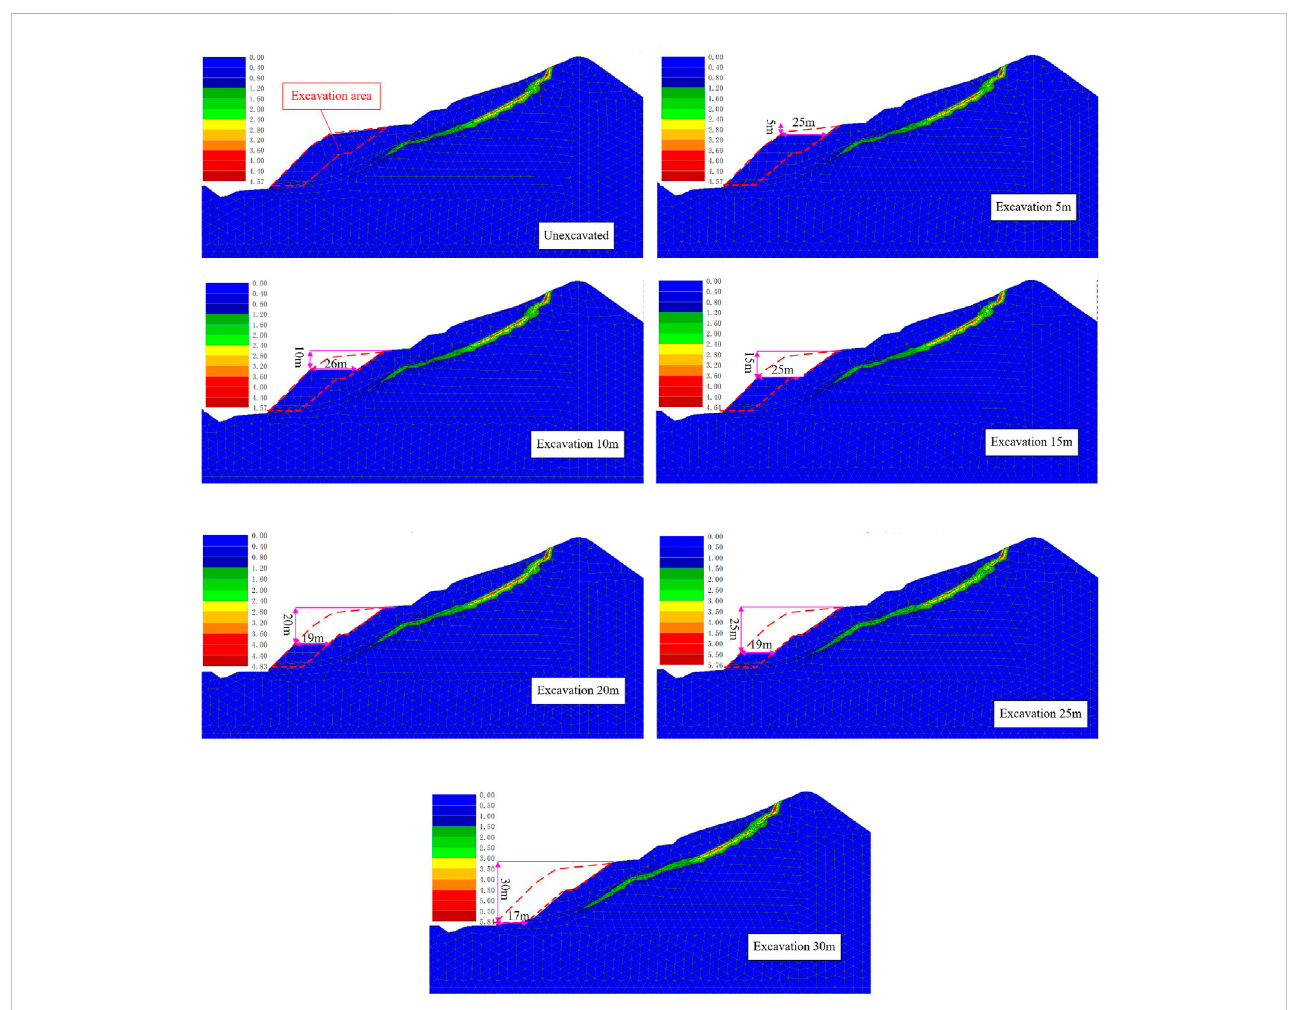
FIGURE 9 Equivalent plastic strain distribution map during excavation.